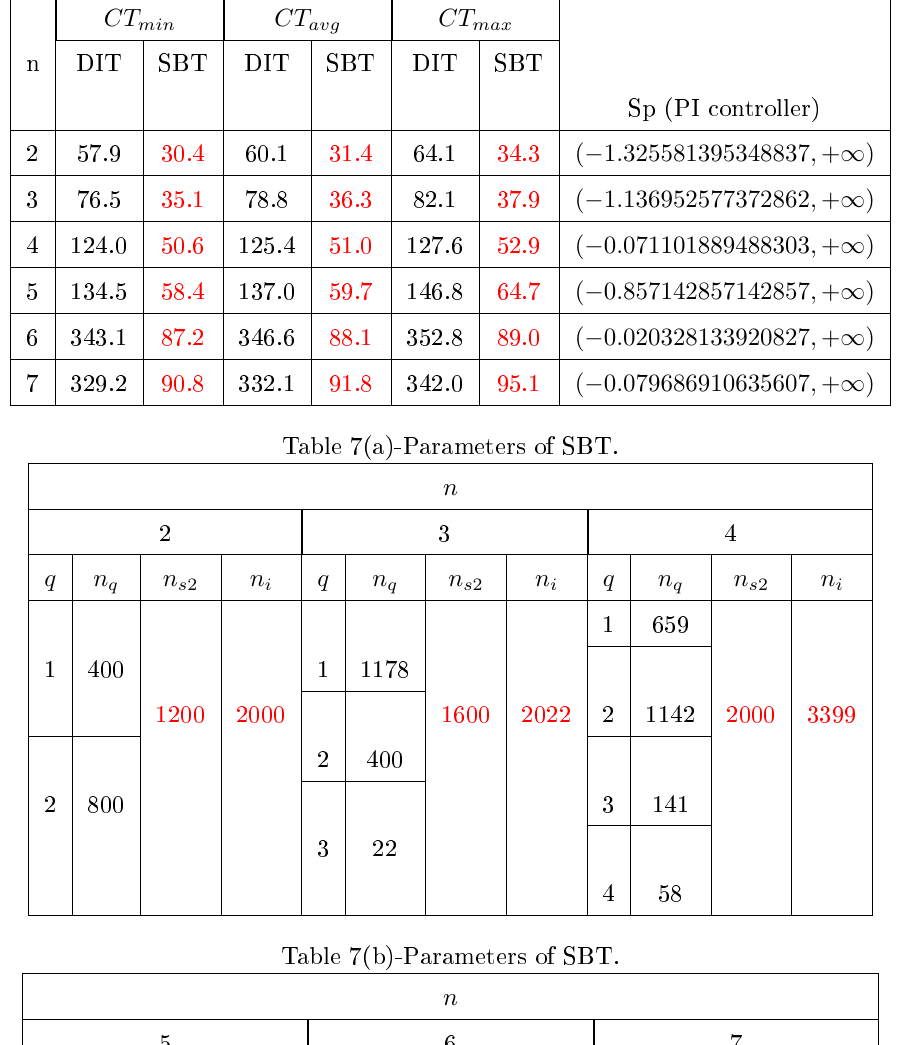
Table 5. Values CT min , CT max , CT avg [ms].